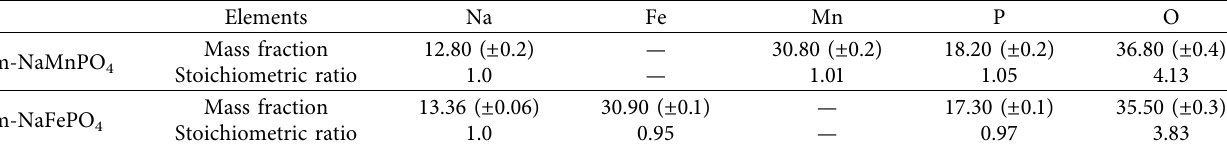
Table 1: Elemental stoichiometry of pristine m-NaMnPO